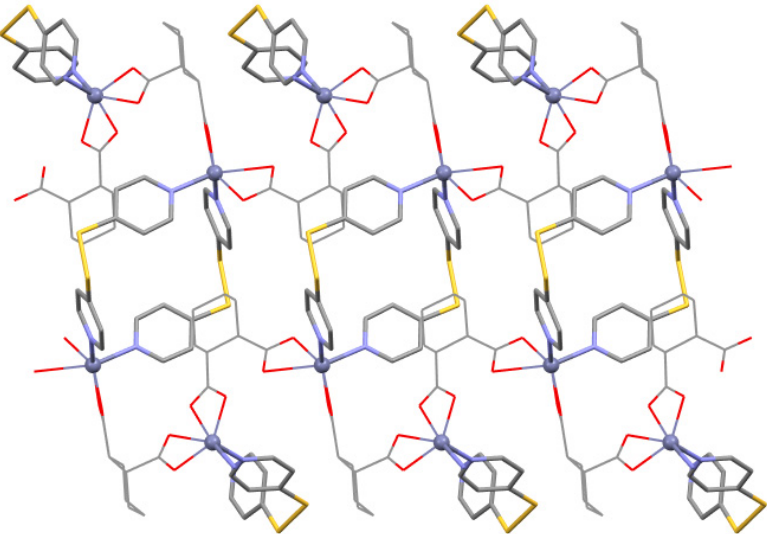
Figure 32. Section of the coordination network in [Zn (EPEYII), viewed perpendicular to the